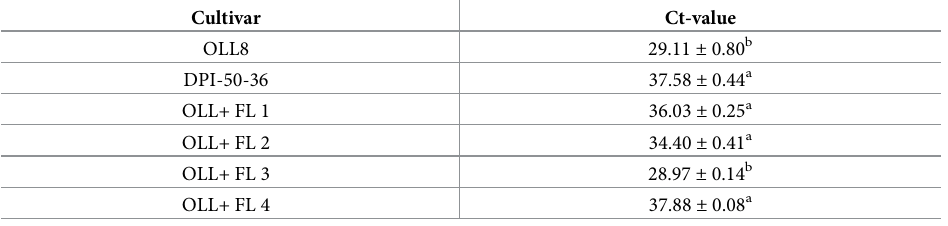
Table 4. Ct values of CaLas detected in the 6-year-old allotetraploid somatic hybrids between OLL8 sweet orange and the finger lime and the diploid